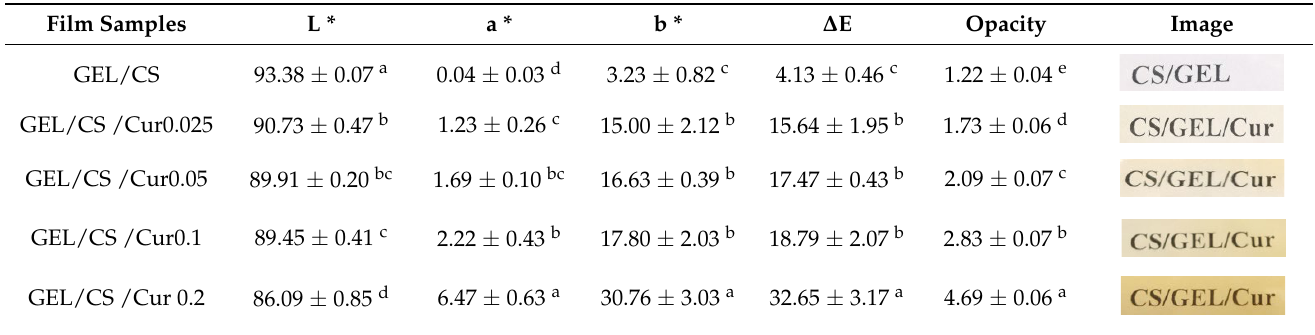
Table 2. Color parameter (L*, a*, b*, and ∆ E*; n = 10), opacity (n = 3) values and digital images of the composite